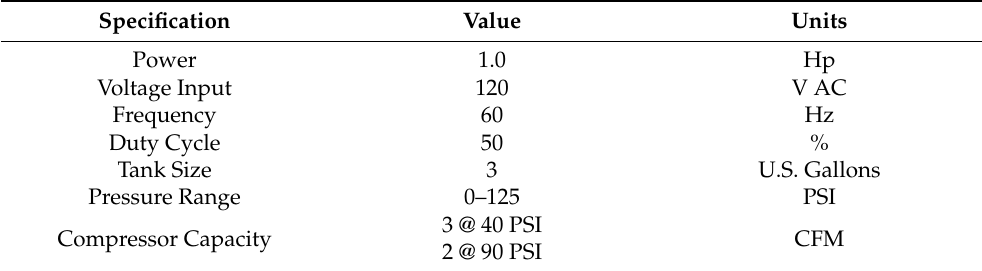
Table 7 summarizes additional technical specifications of the compressor. Table 7. Technical specifications of compressor [37].